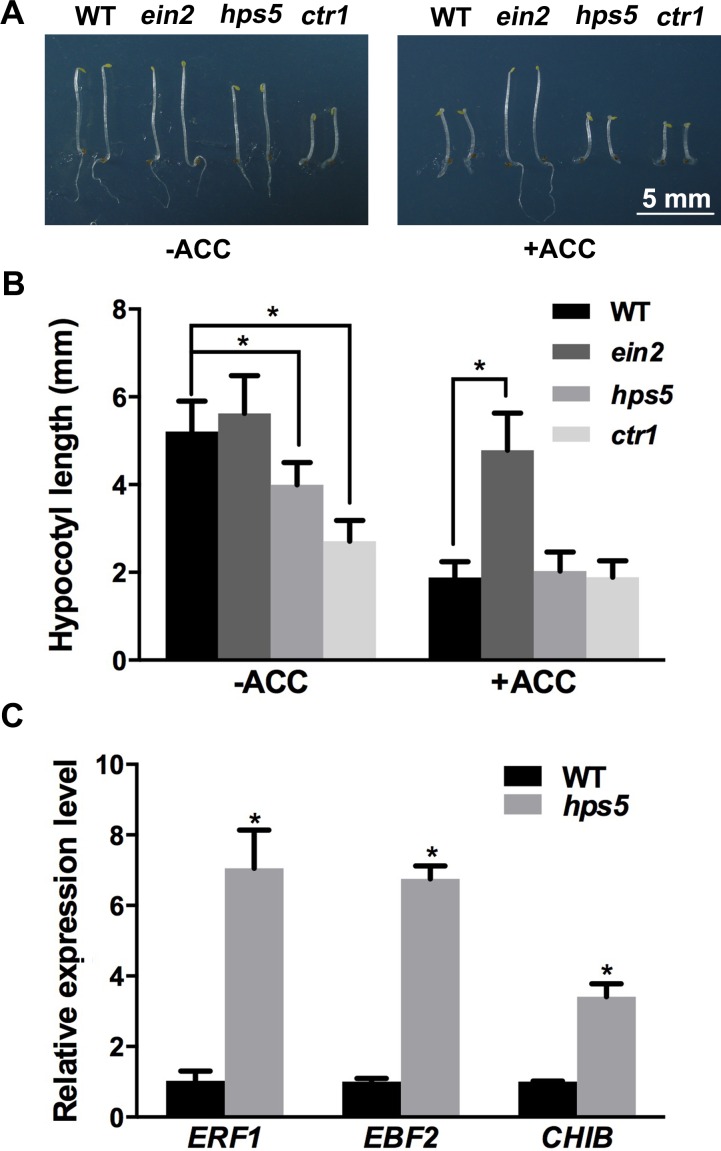
Ethylene responses of the WT and various mutants.(A), Morphology of 4-day-old etiolated seedlings of the WT, ein2, hps5, and ctr1 grown in the dark in the absence or presence of 1 μM ACC. (B), The length of the hypocotyls of the seedlings in (A). Values represent means ± SD of three replicates. (C), Relative expression as determined by qPCR of the ethylene-responsive marker genes in the 7-day-old WT and hps5 seedlings. Values are means ± SD of three technical replications in one experiment that was performed three times with similar results. In (B) and (C), Asterisks indicate a significant difference from the WT (t-test, P < 0.05).